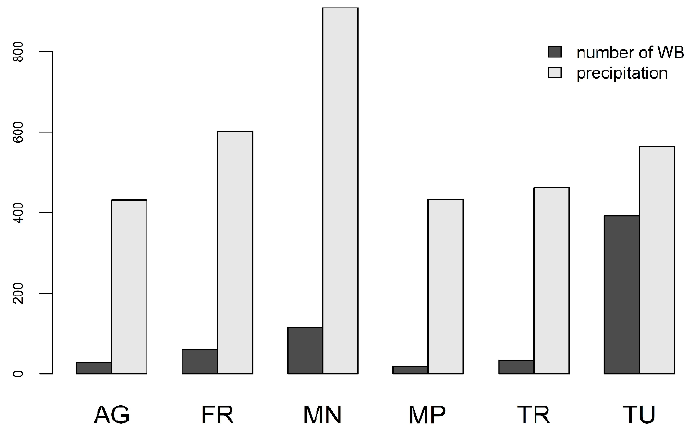
Figure 2. Number of water bodies (WB) and amount of yearly precipitation in assessed landscape types. AG = agricultural landscape; FR = forest landscape; MN = mountain landscape; MP = meadows and pastures; TR = technically reclaimed spoil banks; TU = technically unreclaimed spoil banks.